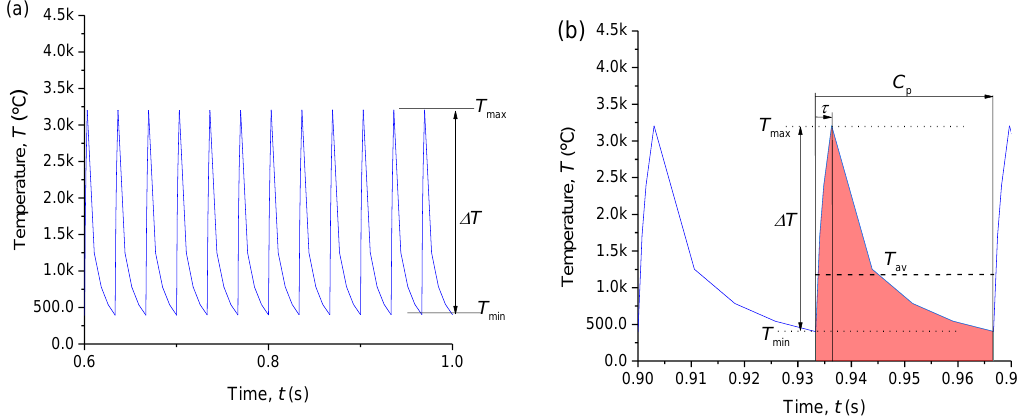
Figure 7. Stable heating stage in Figure 6: ( a ) temperature vs. heating time and ( b ) temperature evolution within a heat pulse duration.